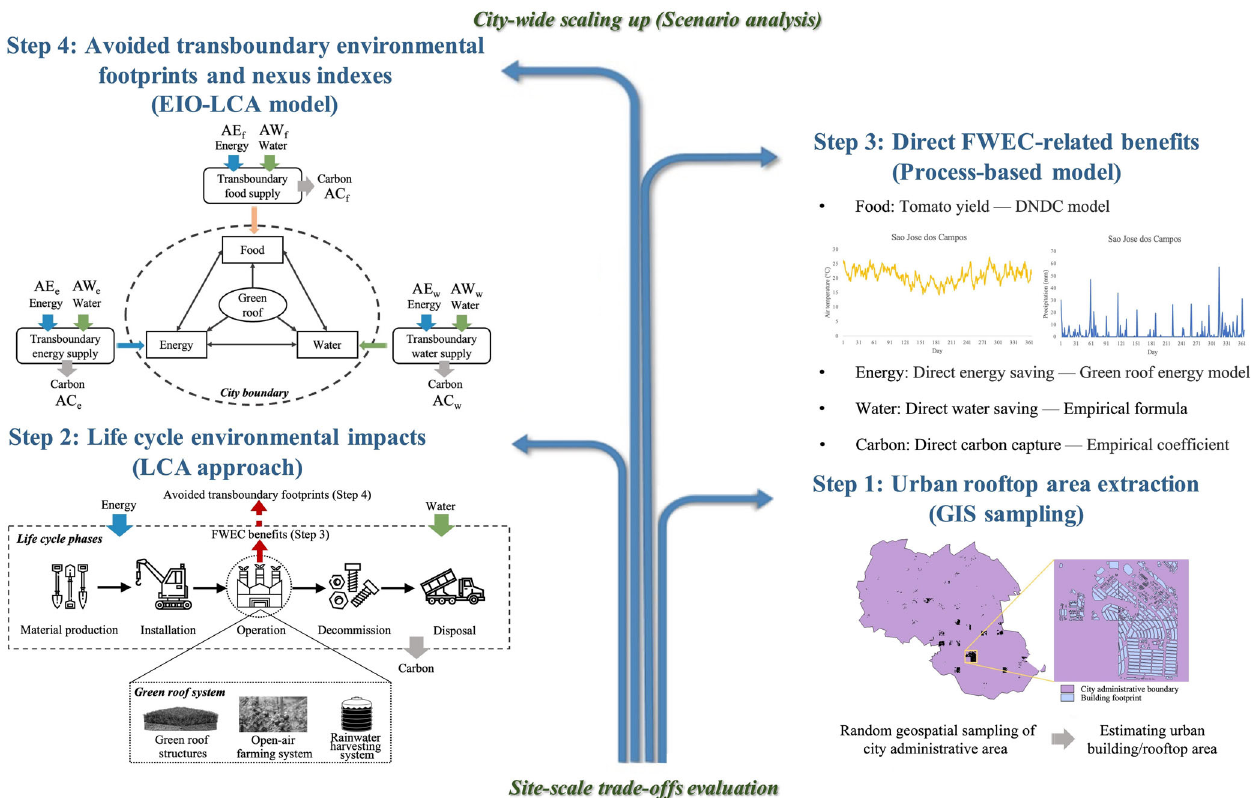
Fig. 1 A generalizable methodology and framework for urban FWE nexus of green roofs. It emphasizes the potential areas for urban green roof development by GIS sampling method (Step 1), green roofs ’ life cycle environmental impacts (Step 2), operational FWEC-related bene fi ts by nested process-based model (Step 3), and consequently avoided transboundary environmental footprints by EIO-LCA model (Step 4). The city-wide scenario analyses were additionally conducted based on the site-scale